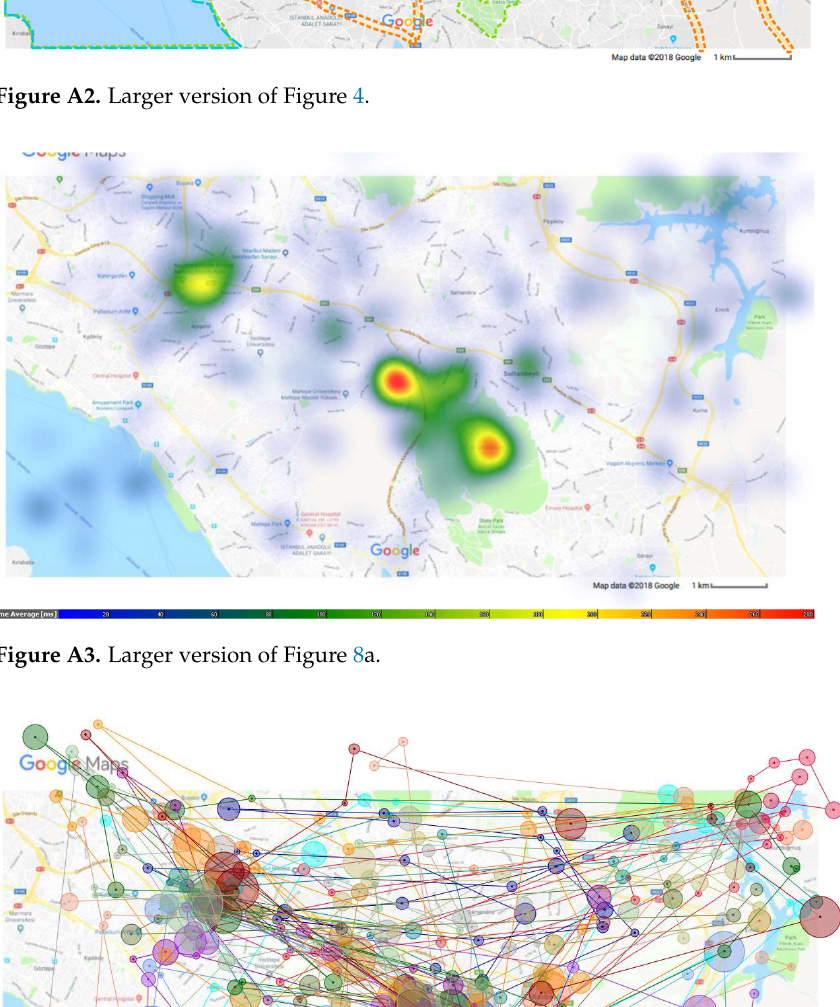
Figure A5. Larger version of Figure 8e.